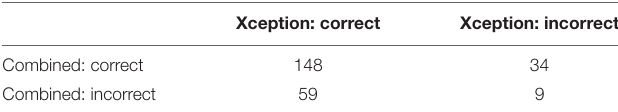
TABLE 1 | Number of adversarial examples classified by performance for the Xception model and the combined model at the perturbation parameter 0.26.